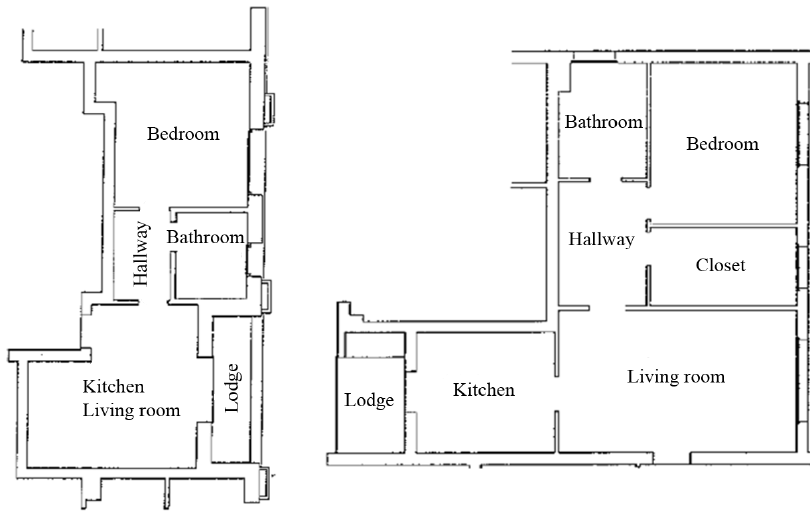
Figure 9. Schematic of plans for some apartments of the pilot